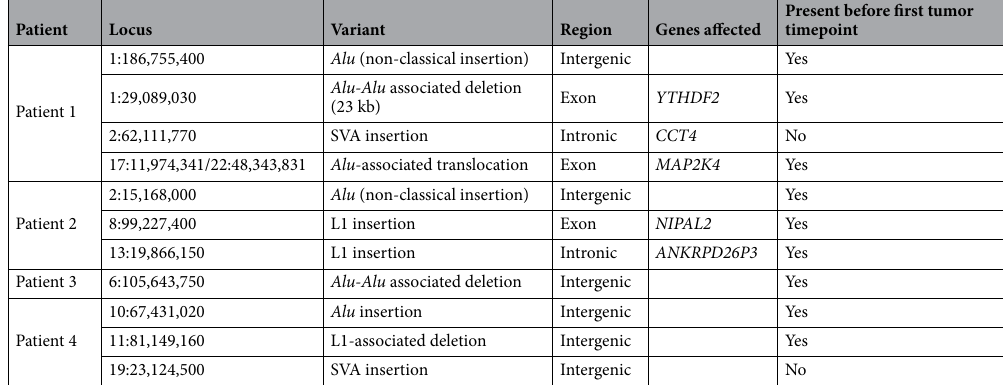
Table 1. Mobile element insertions and structural variants involving mobile elements identified in four longitudinal breast cancer patients. Insertion or variant sites found within genes (exonic or intronic) are indicated in the “Genes affected” column. Insertion events described as “non-classical insertions” do not show any hallmarks of L1-mediated insertion